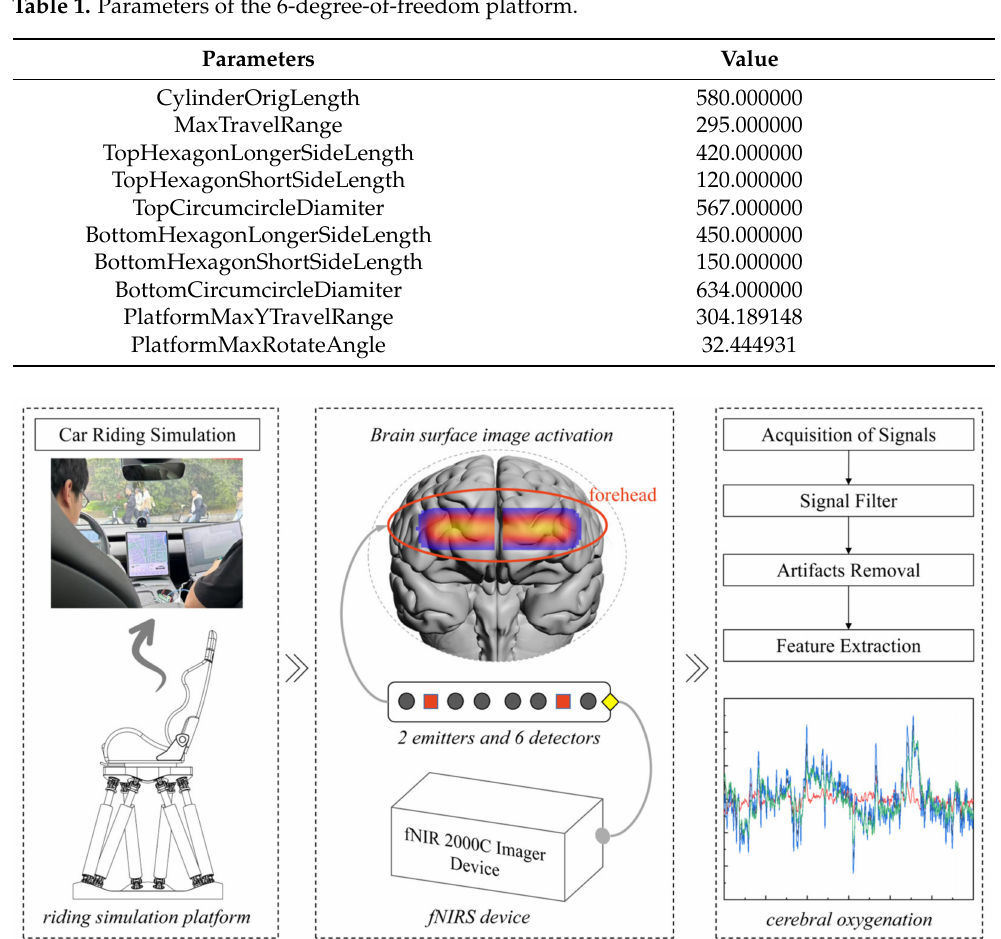
Figure 1. Experimental flow design based on riding